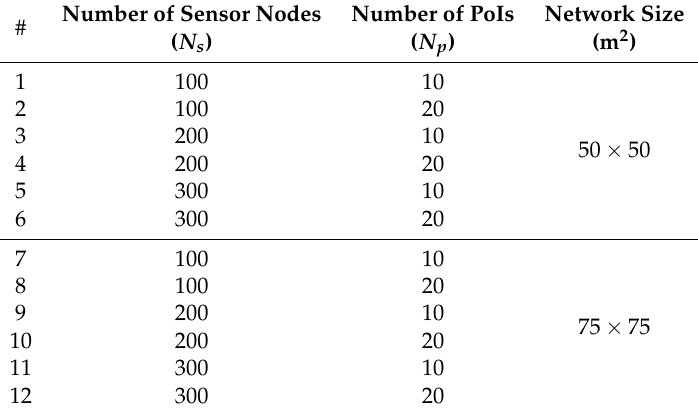
Table 5. Scenarios for the second experiment.